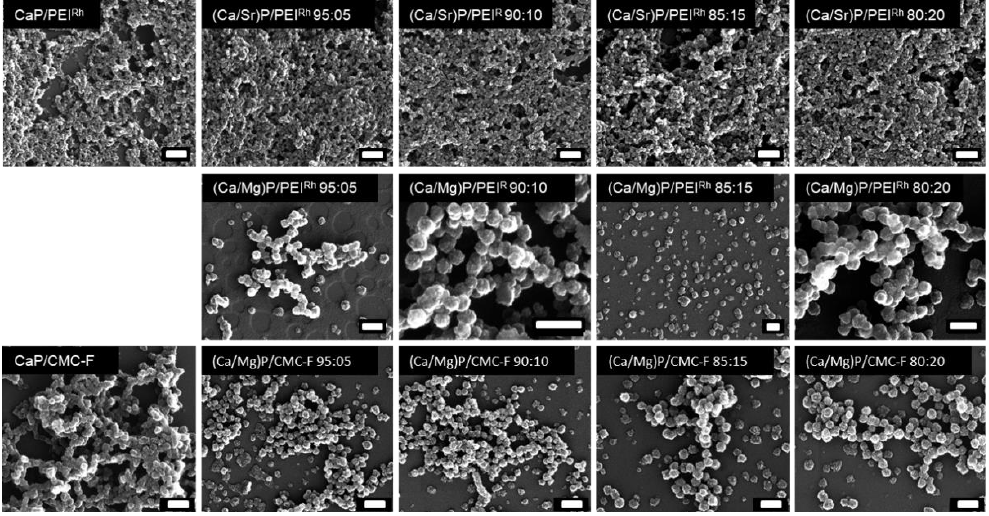
Figure 2. Scanning electron micrographs of undoped calcium phosphate nanoparticles and of strontium- or magnesium-doped calcium phosphate nanoparticles, stabilized and labelled with either PEI Rh or CMC-F. All scalebars: 200 nm.